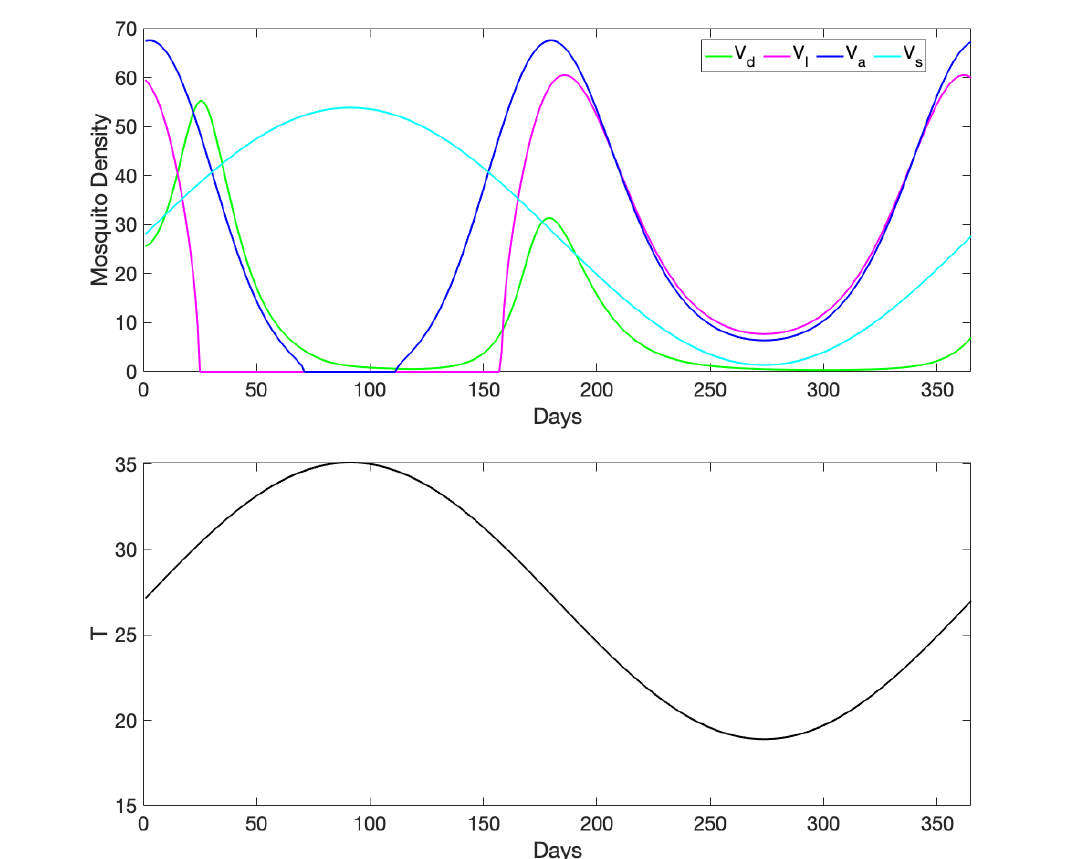
Figure A6. ( Top ) Daily adult females mosquito densities approximated using four forms, namely the sine wave V s with initial V 0 = 33 and amplitude of 0.45, the adult trait-dependent form V a , the life stage trait-dependent V l , and the dynamical density V d ; the parameter values used to solve the ode model are given in Table 1. ( Middle ) Daily temperature given by a sine function ( T 0 ( 1 + B sin ( 2 π t /365 with T 0 = 25 and B = 0.3) evaluated for 365 days used to evaluate our thermal traits incorporated into the dynamical model. ( Bottom ) Densities’ first derivatives calculated to show how each curve changes its gradient as it varies with temperature. The red line shows when the gradient is zero; positive gradient values (above the red line) mean that the density increases; and negative values of the gradient (below the red line) mean that the curve